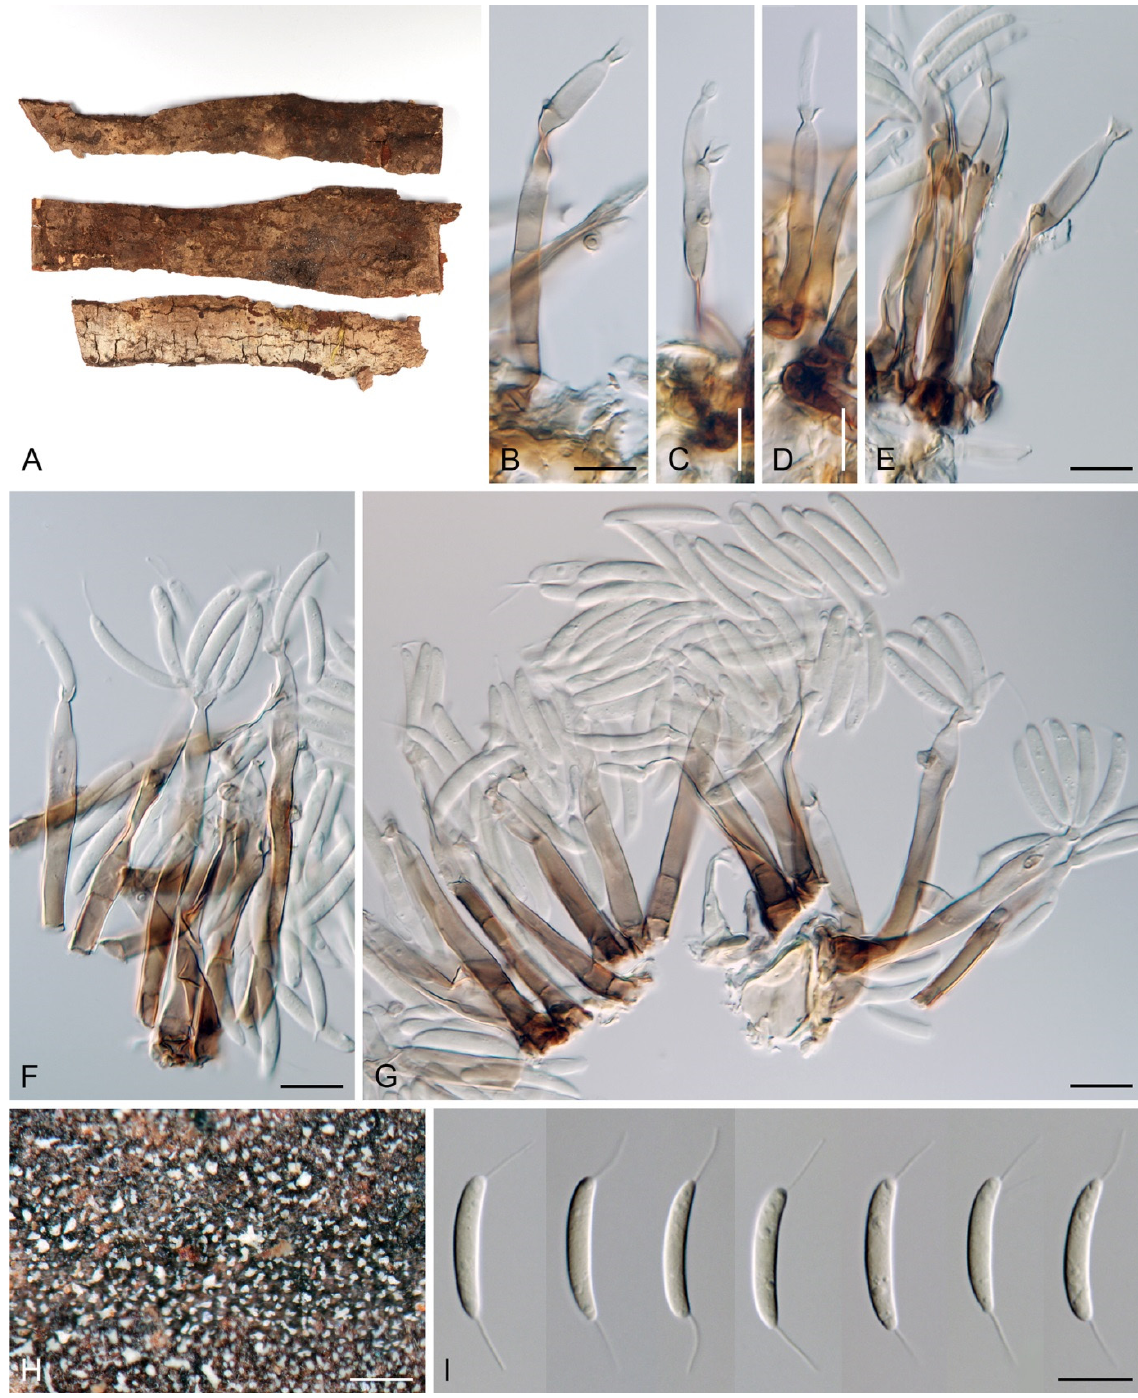
Figure 44. Tainosphaeria simplex (DAOM 96020g isotype). ( A ) Substrate with colonies ( B – G ) conidiophores ( H ) colony on wood ( I ) conidia. Images: ( A – H ) from nature. Scale bars: ( B – G,I ) 10 μ m; ( H ) 500 μ m.